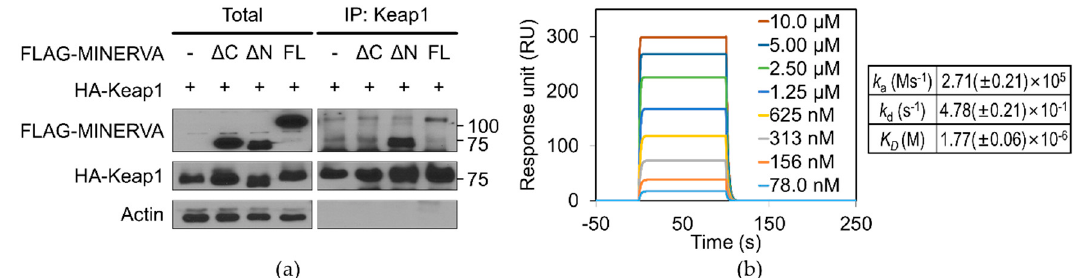
Figure 5. Interaction of MINERVA with Keap1 through its C-terminal region. ( a ) HEK293 cells were co-transfected with HA-tagged Keap1 and either one of the FLAG-tagged MINERVA FL , MINERVA ∆ N , or MINERVA ∆ C . HA-Keap1 was immunoprecipitated with anti-HA with protein A-Sepharose and the immunoprecipitates were examined by western blots using respective antibodies. Actin was used as a loading control. Full blot can be found in Figure S7. ( b ) Surface plasmone resonance (SPR) analysis of MINERVA FL and Keap1 showing micromolar binding affinity between two proteins. The average and standard deviations of k a , k d , and K D are calculated from values obtained from two separate experiments.